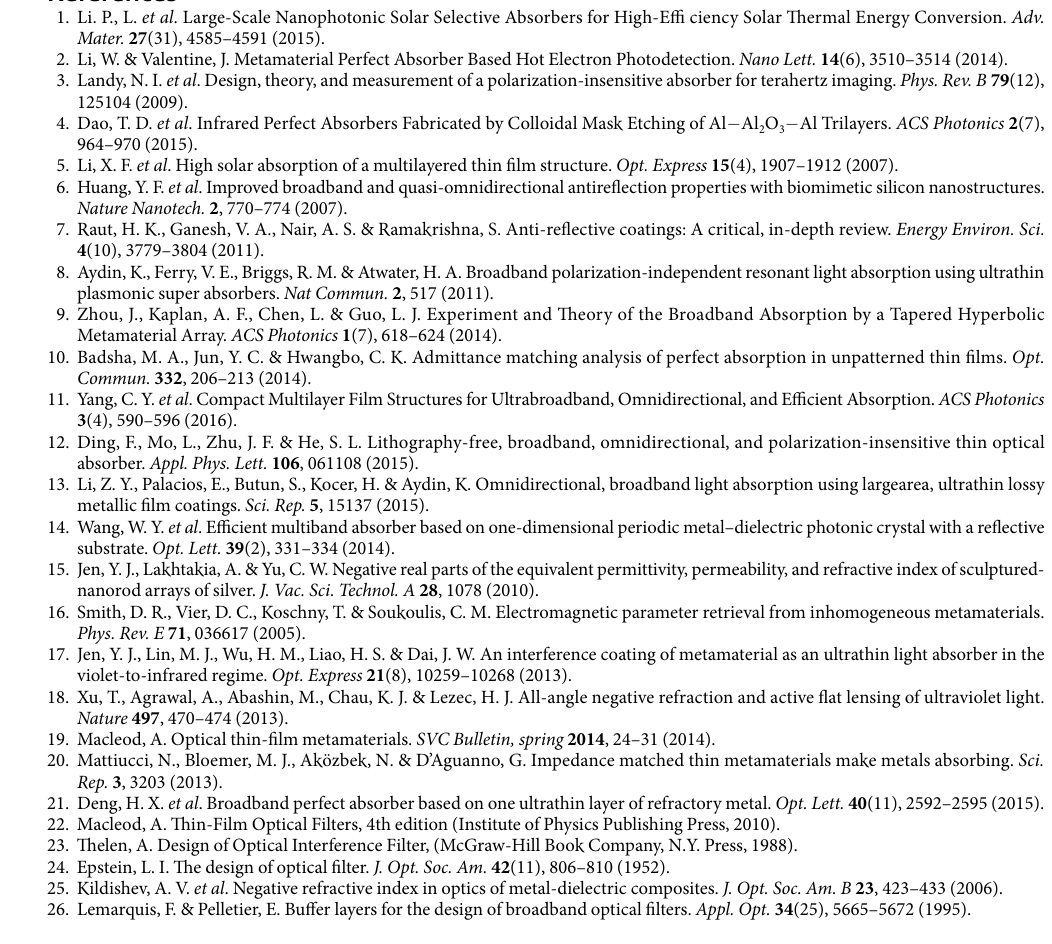
design of an admittance matching layer with any number of thin films to form a symmetric unit cell. The equiv- alent layer exhibits not only near-perfect antireflection but also strong light extinction. The combination of these optical properties, which traditionally conflict with each other, enables an ultra-thin light absorber to be fabri- cated. An example demonstrates that a five-layered metamaterial provides more flexibility than a three-layered metamaterial in the design of a broadband and wide-angle admittance matching layer. Admittance matching at visible wavelengths and destructive interference at infrared wavelengths provide high absorption over a broad band. A seven-layered metamaterial is designed with a large extinction coefficient and admittance matching with air. With a thickness of only 192 nm, the metal-like metamaterial absorbs more than 97% of the energy of incident visible light. Based on this work, more thin films with a tailored refractive index and equivalent admittance can be designed, opening up a new avenue in the development of optical coatings for novel optical devices.